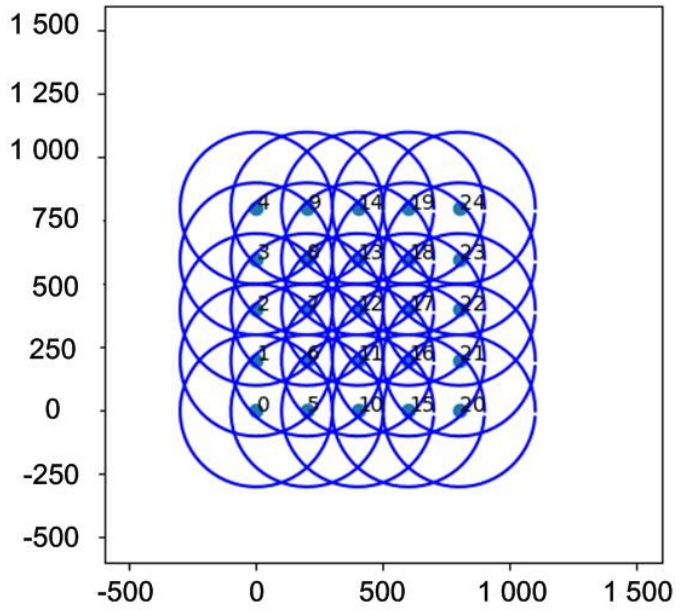
Figure 7. Node distribution in a sensor network consisting of 25 nodes. Dots denote sensor nodes, and the number beside indicates the ID of the sensor node. The ring around a dot is the communication range of the node. The edge of each grid is 200 m, and the communication range for each node is 300 m.